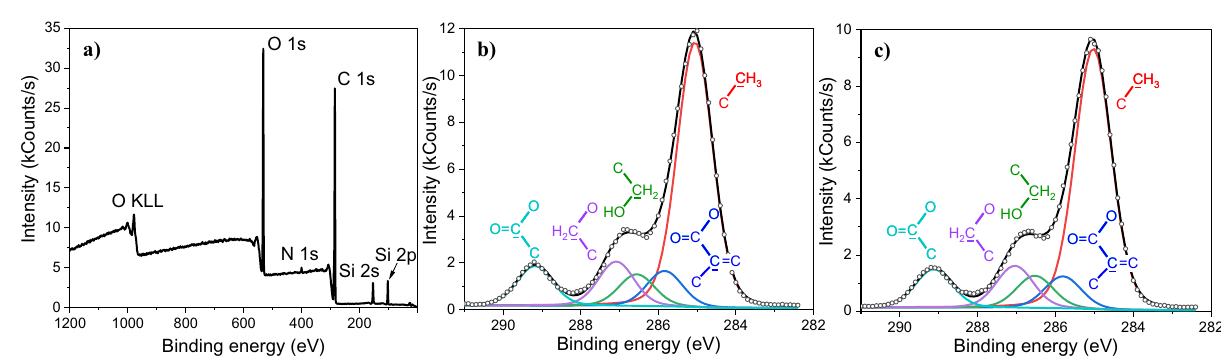
Binding energy Figure 6. Photoelectron spectra of the dried PHEMA surface with shown components in the ( a ) survey spectrum and the detailed C 1s spectra of ( b ) unmodified and ( c ) modified surface with fitted